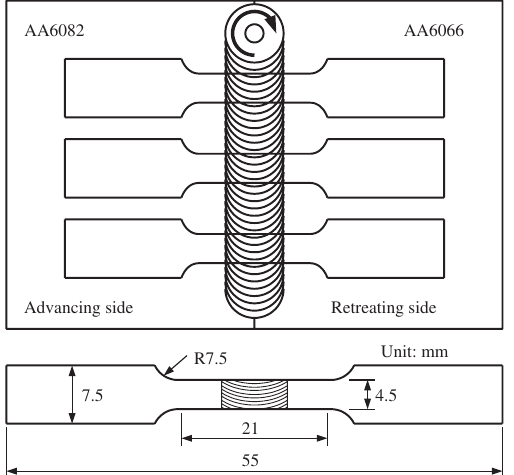
Figure 2: Dimension and locations of the tensile specimen sam- pling in dissimilar metal